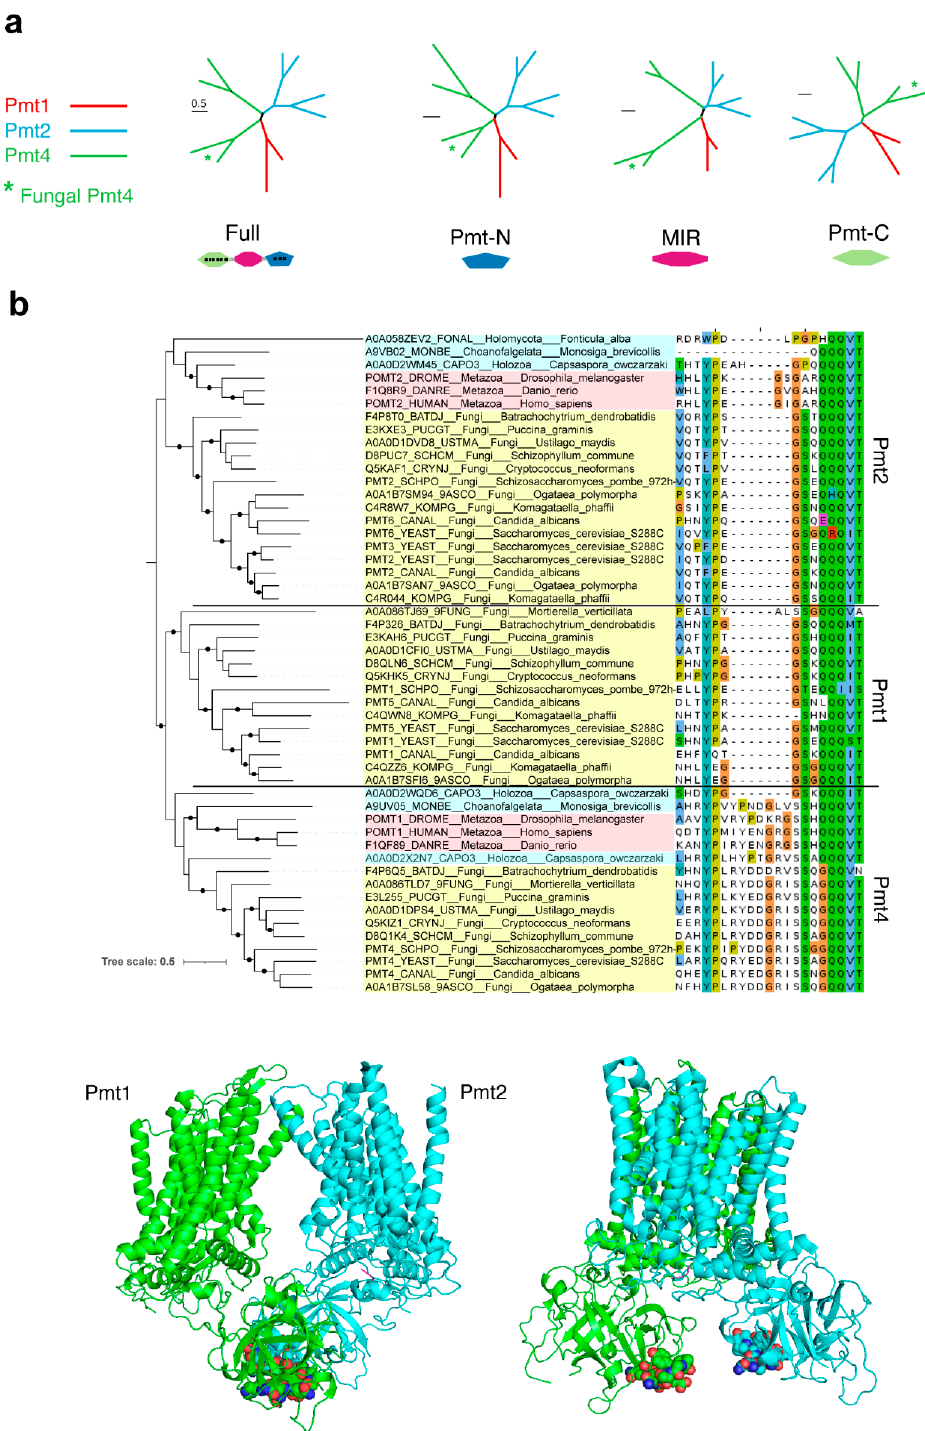
Figure 3. The origin of fungi-specific Pmt1 might be Pmt4. ( a ) Phylogenetic distances of the whole Pmt protein and single domains between the Pmt sequences of Homo sapiens, Drosophila melanogaster, Saccharomyces cerevisiae , and Ustilago maydis . ( b ) Phylogeny of eukaryotic Pmt proteins ( left ) and multiple sequence alignment of the region with an indel between the positions 387 and 388 ( U. maydis Pmt2 positions) within the MIR domain, common in Pmt2 and Pmt1 ( right ). Labels were highlighted according to the taxonomy: blue, early branching opisthokonts; pink, metazoan; and yellow, fungi. Black cir- cles at nodes indicate bootstraps higher than 90. A ribbon representation of the structure of the Pmt1 and Pmt2 dimer (PDB code 6p25) is shown below, with the residues surrounding the indel represented in spheres.